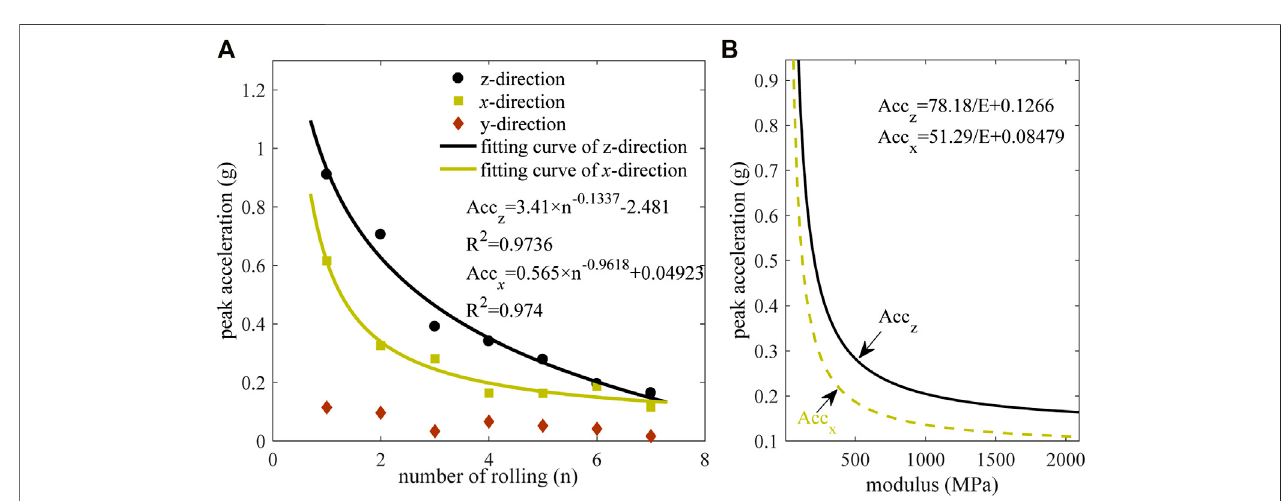
FIGURE 12 | (A) Peak value of acceleration; (B) relation curve between modulus and acceleration.